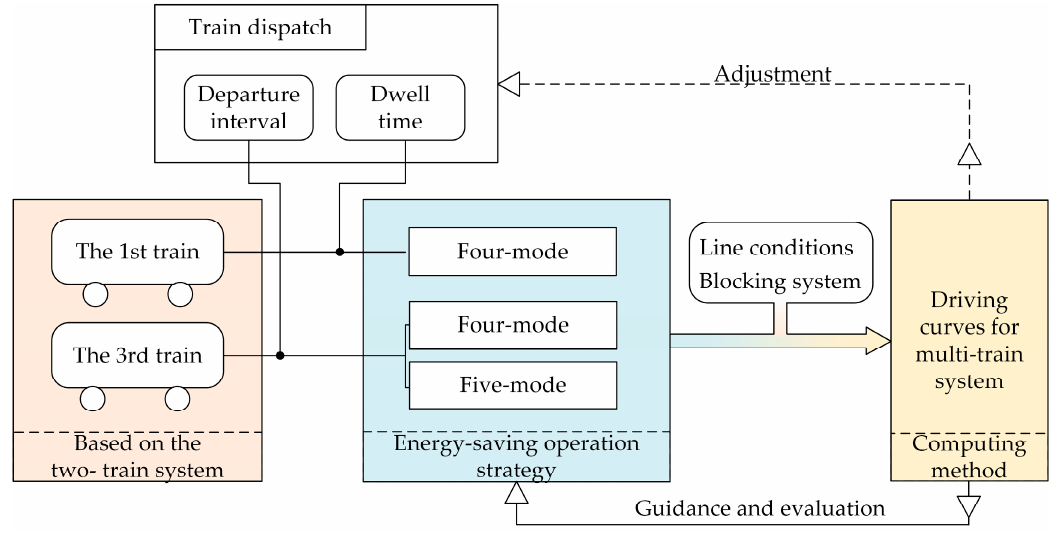
Figure 14. The conclusion of proposed energy-saving operation strategy.